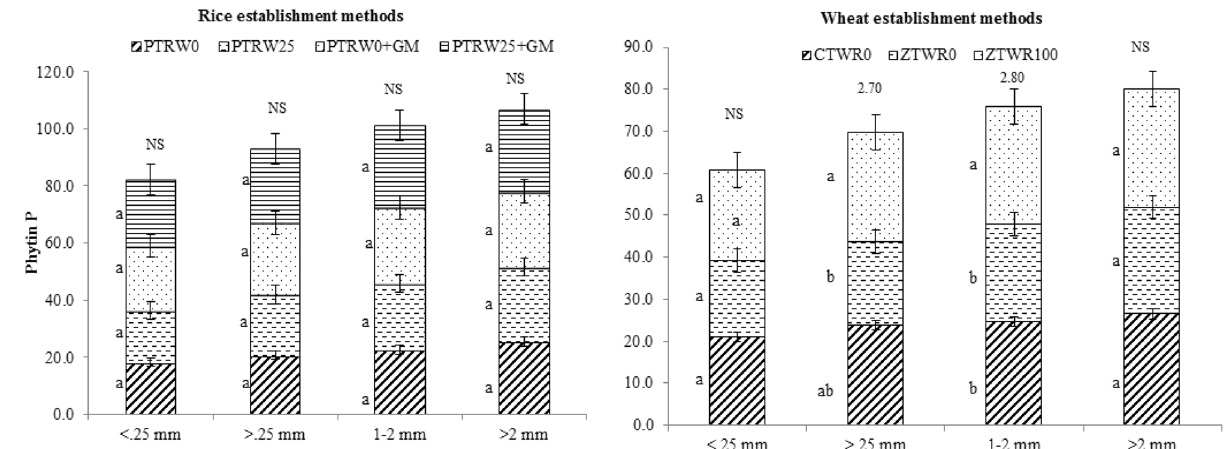
Figure 6. Effect of tillage, green manure and residue management practices on phytin-P within aggregates after five years of rice–wheat cropping system. PTR W0 -puddled transplanted rice with no wheat straw, PTR W25 - puddled transplanted rice with 25% anchored wheat straw retained, GM-Green manure, CTW R0 -conventional tillage wheat with rice straw removed, ZTW R0 -zero tillage wheat with rice straw removed, ZTW R100 -ZTW with rice straw retained as surface mulch. Vertical bars are the standard errors of the mean ( p < 0.05 ). The values above the vertical bars represent least significant difference